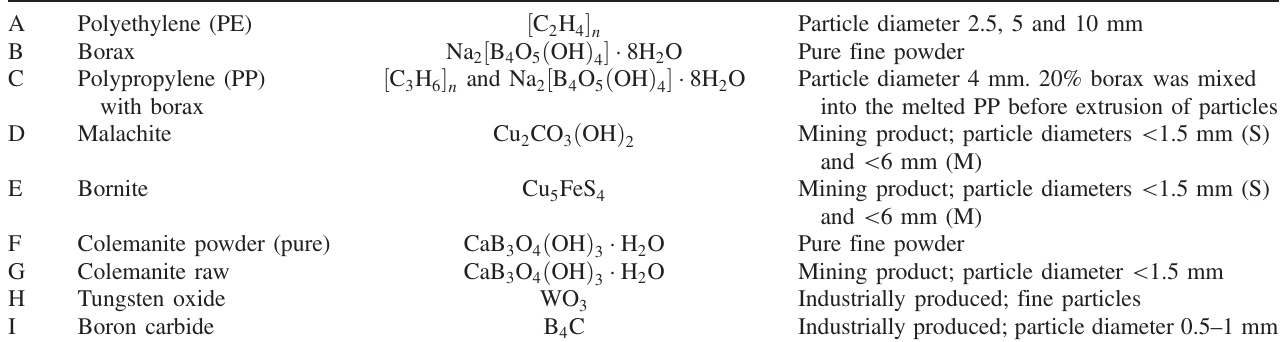
TABLE I. The tested aggregates. The chemical formulas are for the chemically pure compounds.